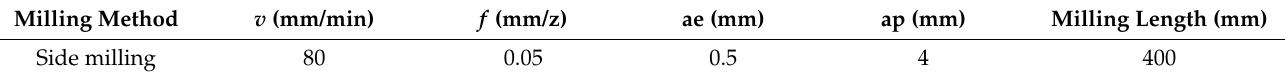
Table 8. Cutting parameters.